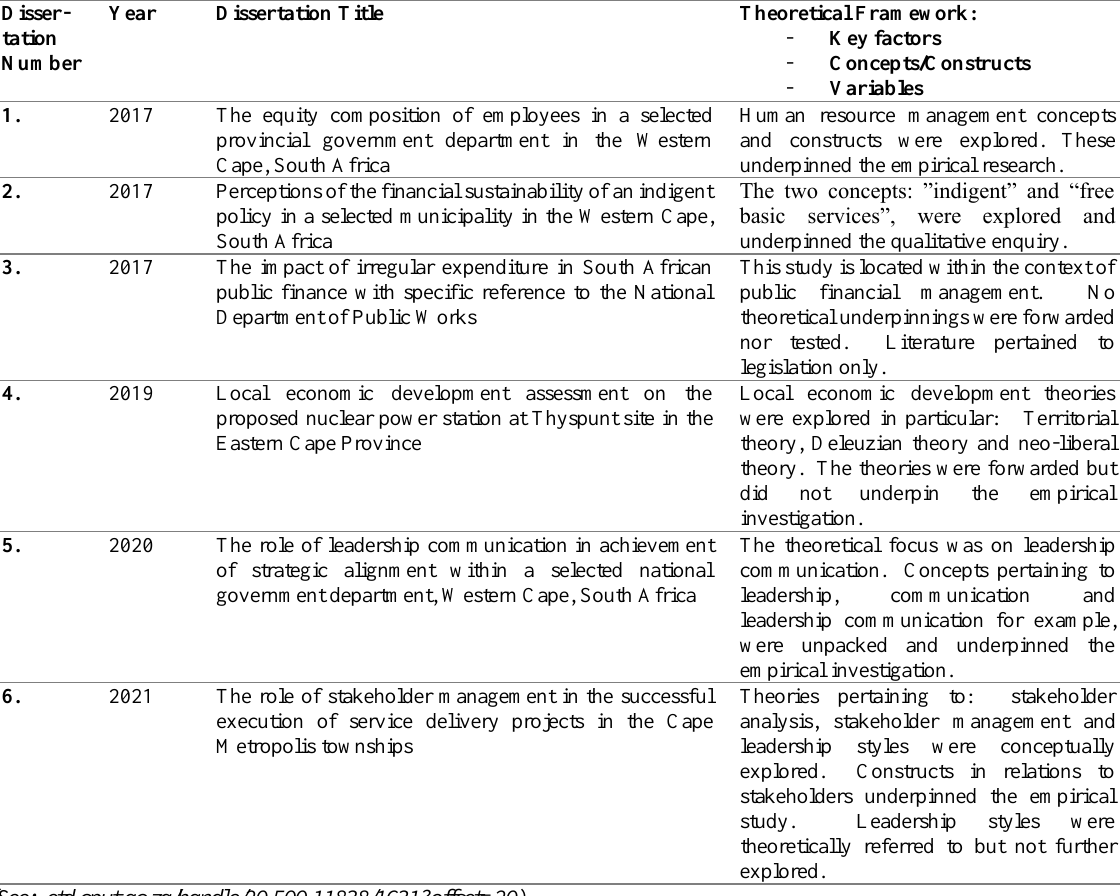
Table 2: Master of Public Administration degrees